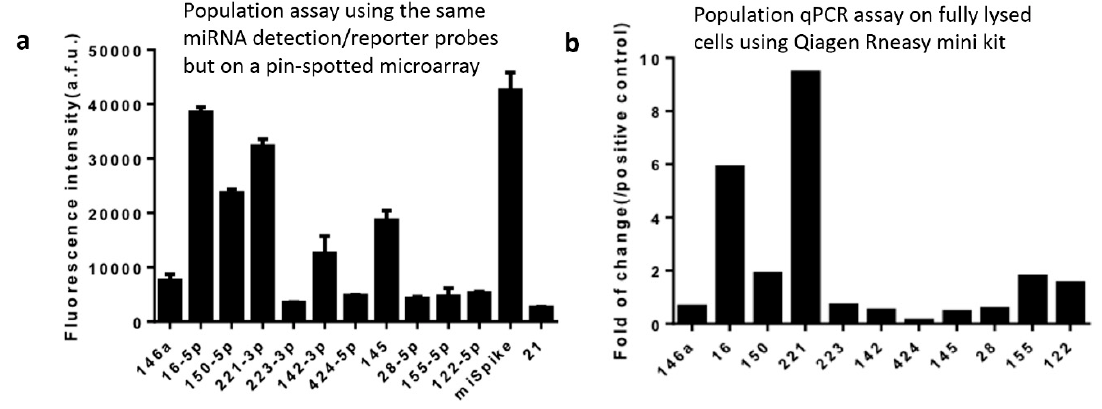
Figure 4. Population validation. ( a ) Population level measurement of microRNAs in THP-1 cells using the same in situ hybridization workflow in Figure 1 and the same reagents including microRNA detection/reporter probes and the DNA barcode array slide except that the UV-cleaved reporter probes were collected in the bulk supernatant and the DNA barcode array was fabricated using conventional pin-spotting. ( b ) qPCR result of THP-1 cell population experiment conducted using the standard cell lysis, RNA extraction, and qPCR workflow rather than in situ hybridization. The y-axis is the fluorescence intensity of certain kinds of miRNAs compared with the positive control U6. The x-axis represents 11 endogenous miRNAs and two controls.